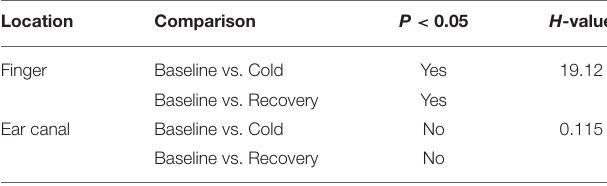
TABLE 2 | Statistical test results obtained from the non-parametric analysis performed on the LF/HF ratio measured from the finger and the ear canal